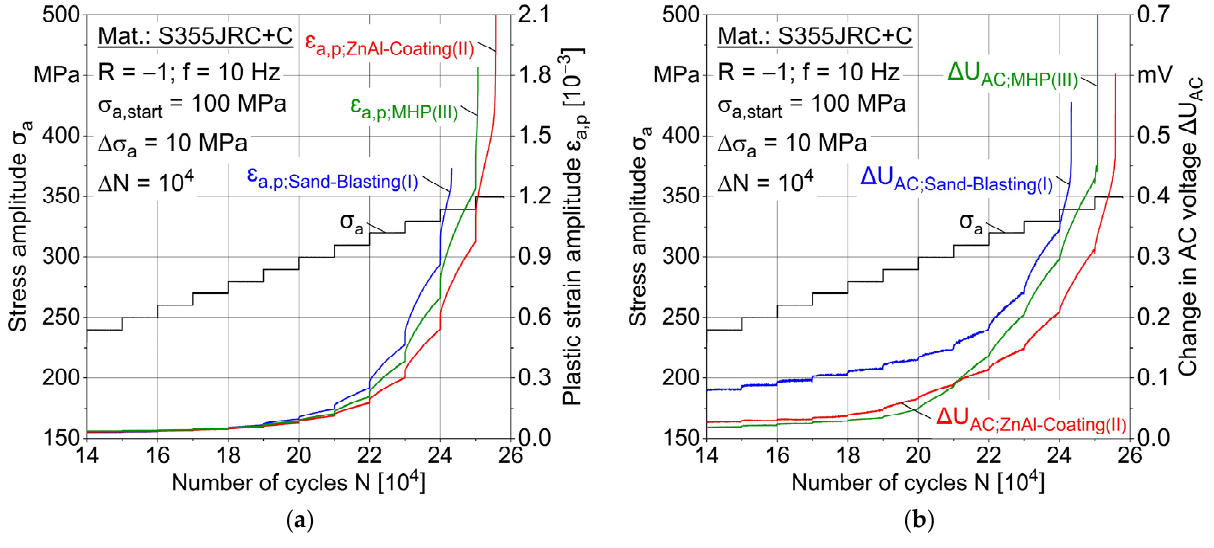
Figure 14. Plastic strain amplitude and change in AC voltage for multiple amplitude test (MAT) for sand-blasting (I), ZnAl-coating (II) and machine hammer peening (MHP) (III), comparison of ( a ) plastic strain amplitude, ( b ) change in AC voltage.